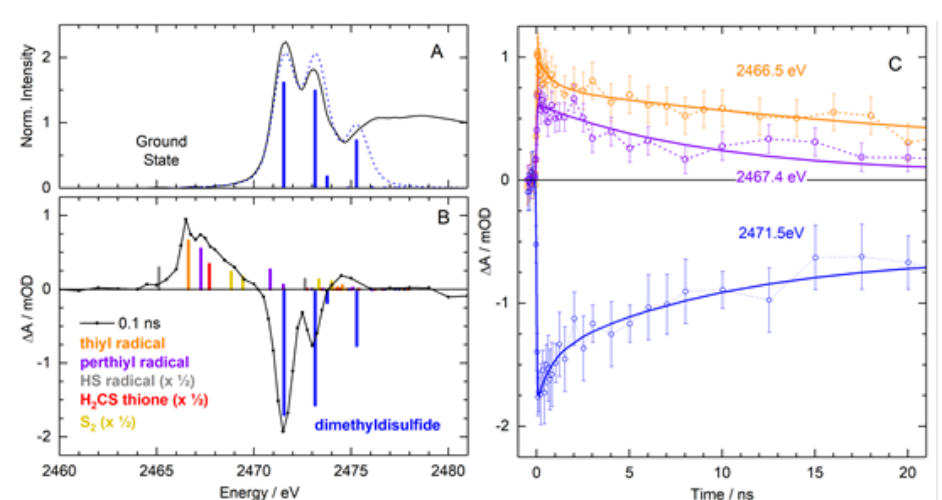
Fig. 2. A. Static XAS spectrum of 2 with the RASSCF calculated bound-bound transitions (blue). B . Differential spectrum at 100 ps delay with lowest RASSCF transitions of transient photoproducts ( II orange, III purple, 3 yellow, 4 red and IV grey). C. Transients and fits of exponential decays